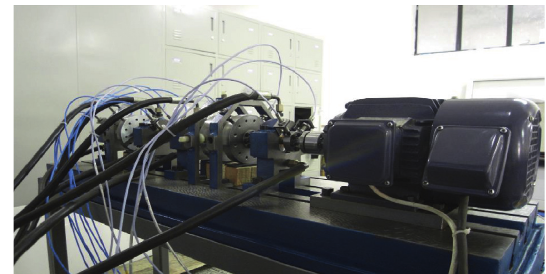
Figure 5: The two-span rotor-bearing